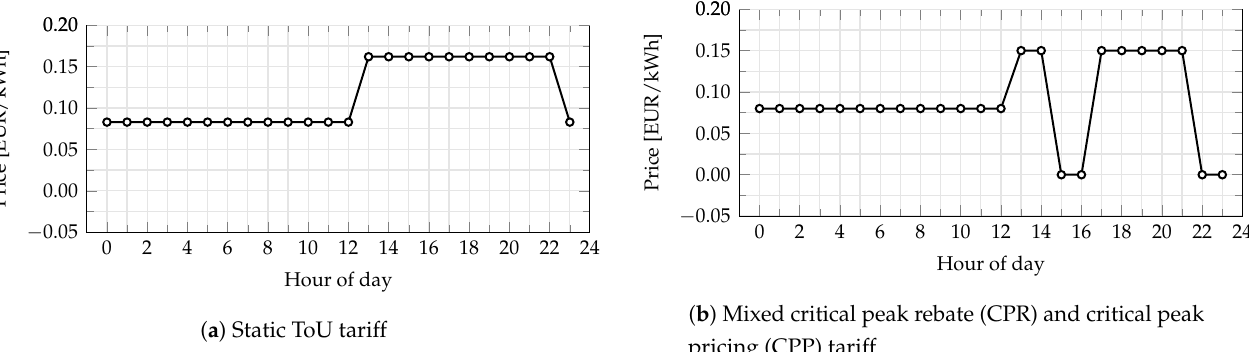
Figure 5. An example of time of use (ToU) tariffs that can be utilized for implicit demand response